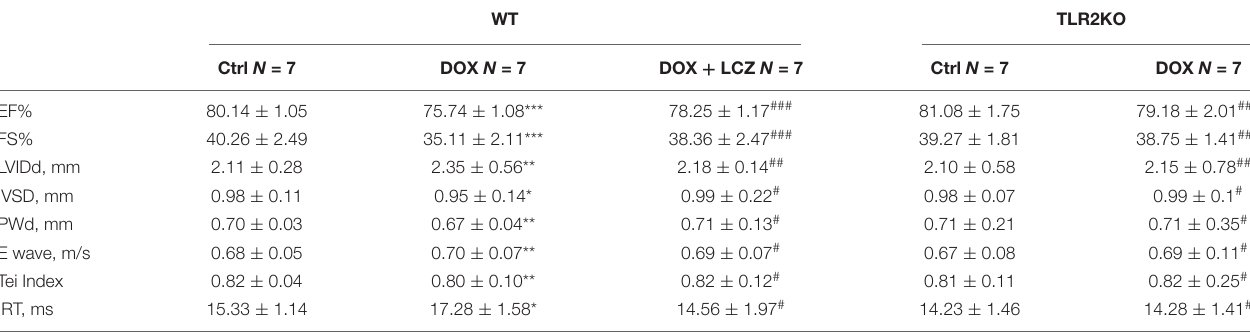
TABLE 1 | Biometric and echocardiographic parameters of the experimental mice.